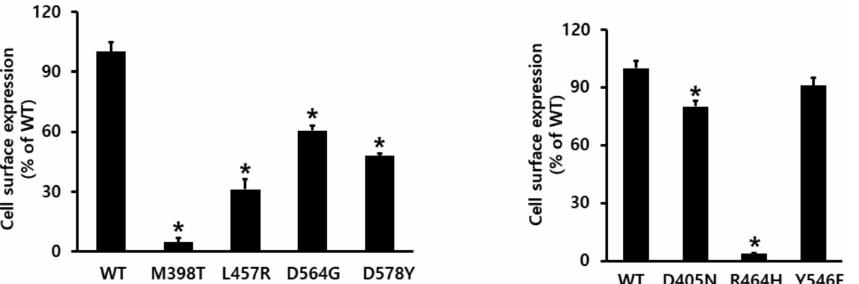
Figure 2. Cell-surface expression of eLH/CG receptors in transiently transfected HEK-293 cells. An enzyme-linked immunosorbent assay (ELISA) was used to determine the surface expression levels of the wild-type receptor and the indicated mutants of eLH/CGR. Data are presented as the means ± SEM of three independent experiments, and were normalized to the data for the wild- type. Cell-surface expression in the wild-type was considered as 100% (see Methods and Materials). * Statistically significant differences in cell-surface receptor expression ( p < 0.05) compared to the expression of the wild-type receptor.